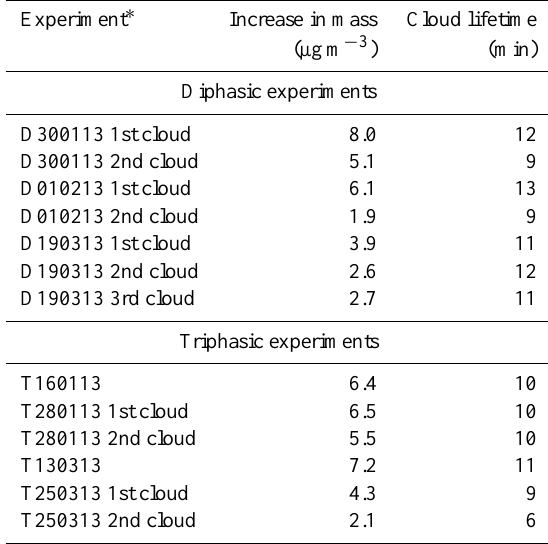
Table 3. Summary of the maxima increases of the total particle mass concentration observed during cloud events for diphasic and tripha- sic